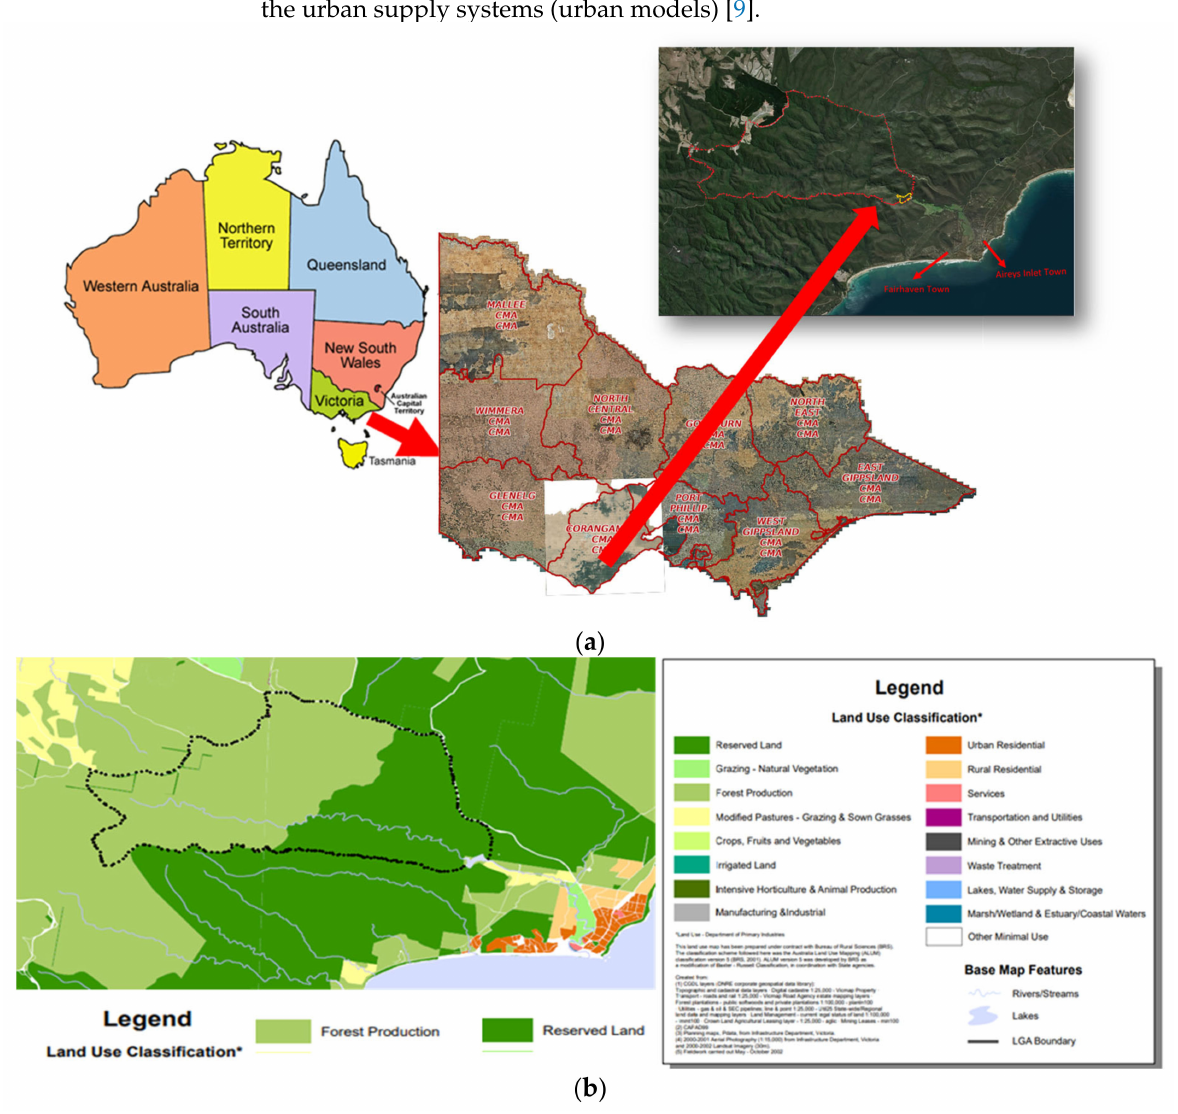
Figure 1. ( a ) Location and area map of the Painkalac catchment; ( b ) land-use map of the Painkalac catchment adapted from